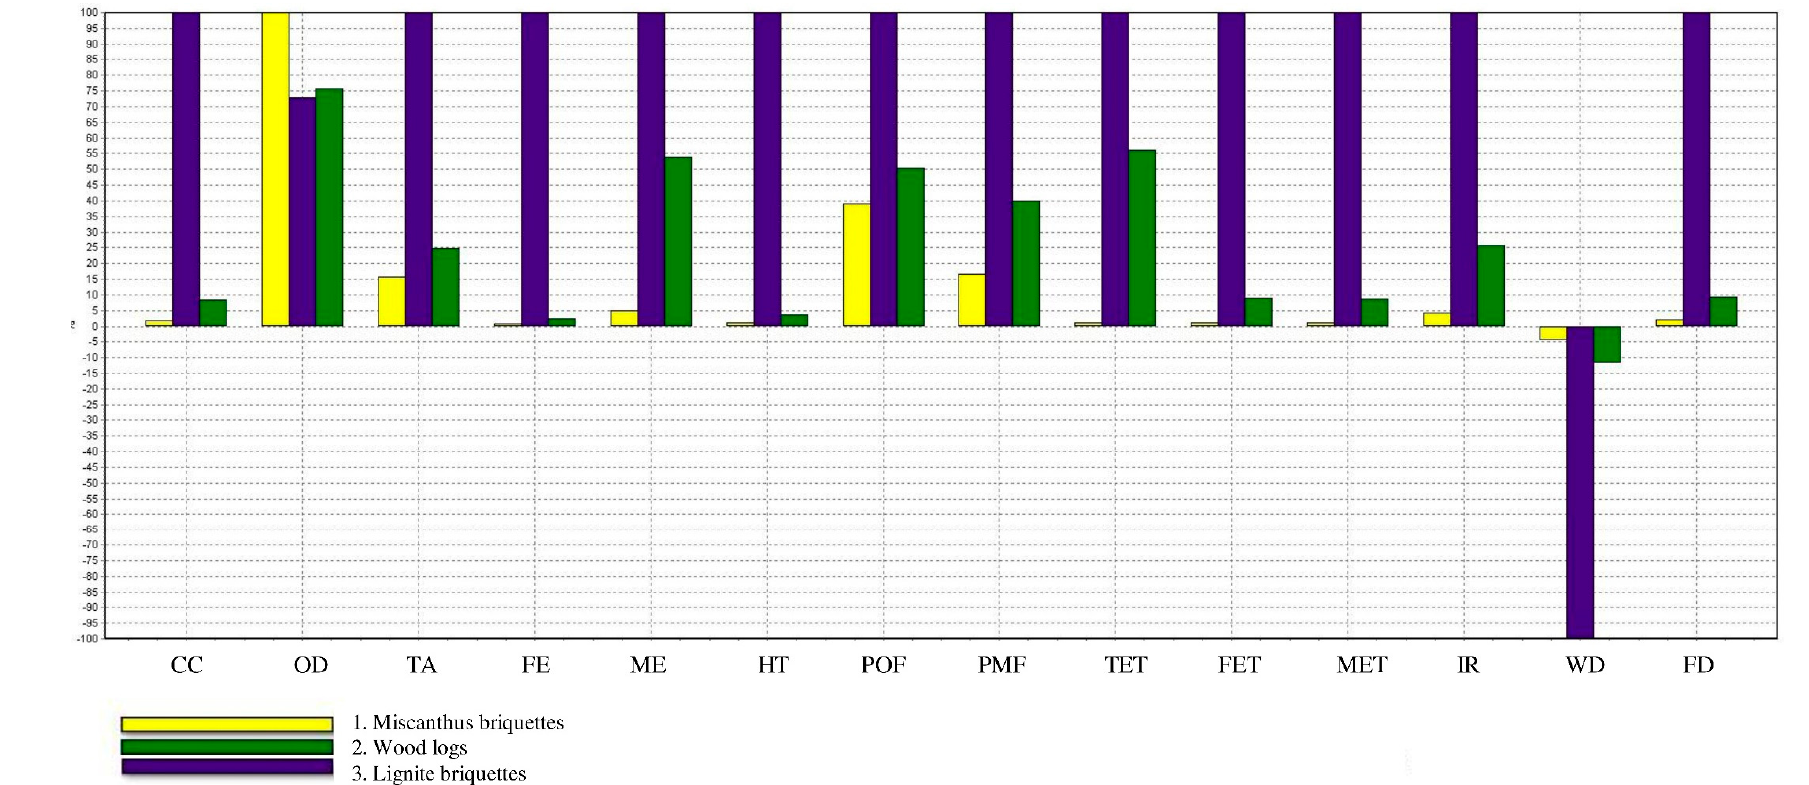
Figure 3. Comparative LCIA for Miscanthus briquettes, wood logs and lignite